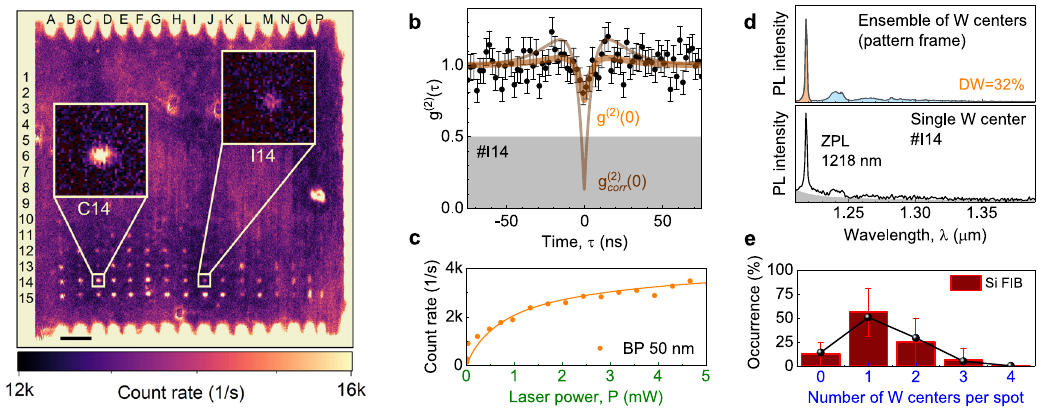
Fig.4|SingleWcentersinultrapuresilicon.a ConfocalPLintensitymapoflocally created Wcenters. Thepatternframe iscreatedwitha fl uence Φ =1×10 11 cm − 2 .The PLiscollectedusingaBP fi lter Δ λ =50nmat λ =1225nm.Thescalebaris20 μ m.The insets show the PL from two W centers ( # C14) and a single W center ( # I14). b Second-orderautocorrelationfunction g (2) ( τ )obtainedatthespot # I14withnoBG correction.TheBGcorrection(thinsolidline)gives g ð 2 Þ corr ð 0 Þ =0 : 13 +0 : 35 (cid:1) 0 : 13 . c Countrate ofasingleWcenterafterBGsubtractionasafunctionoftheexcitationpower,which